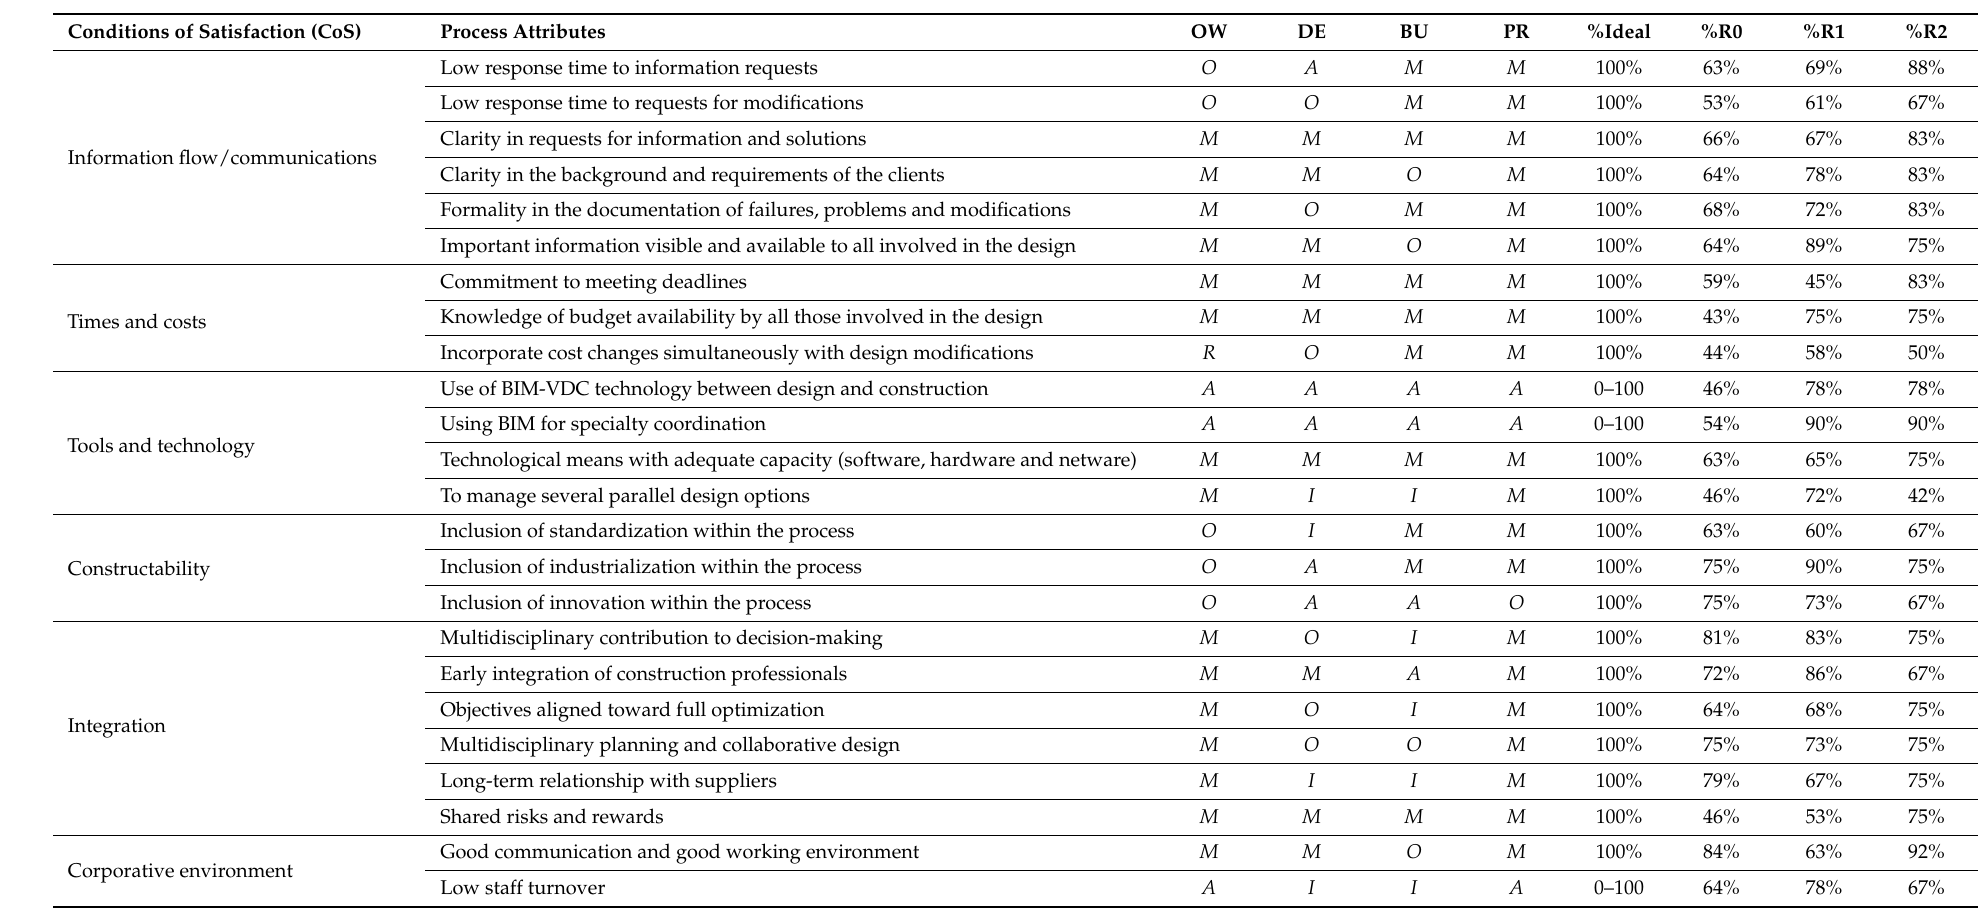
Table A1. Process conditions of